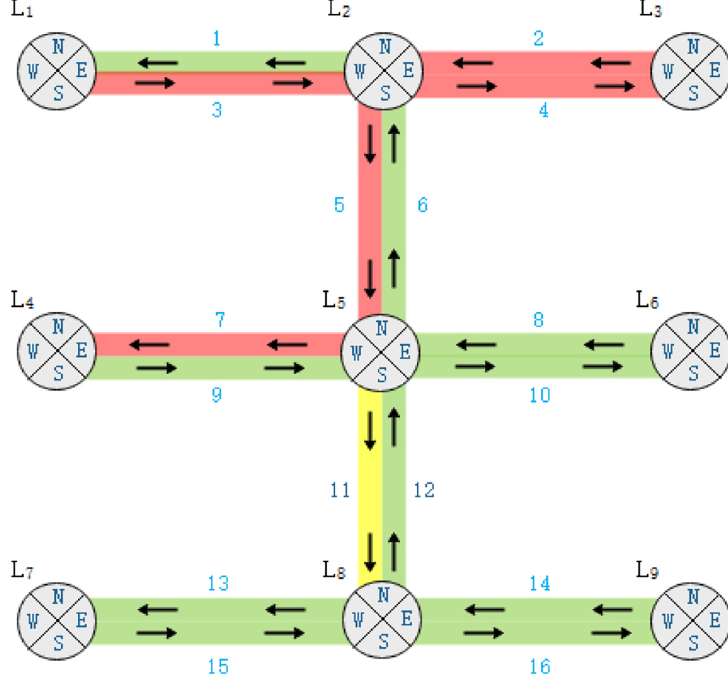
Figure 3. Road conditions